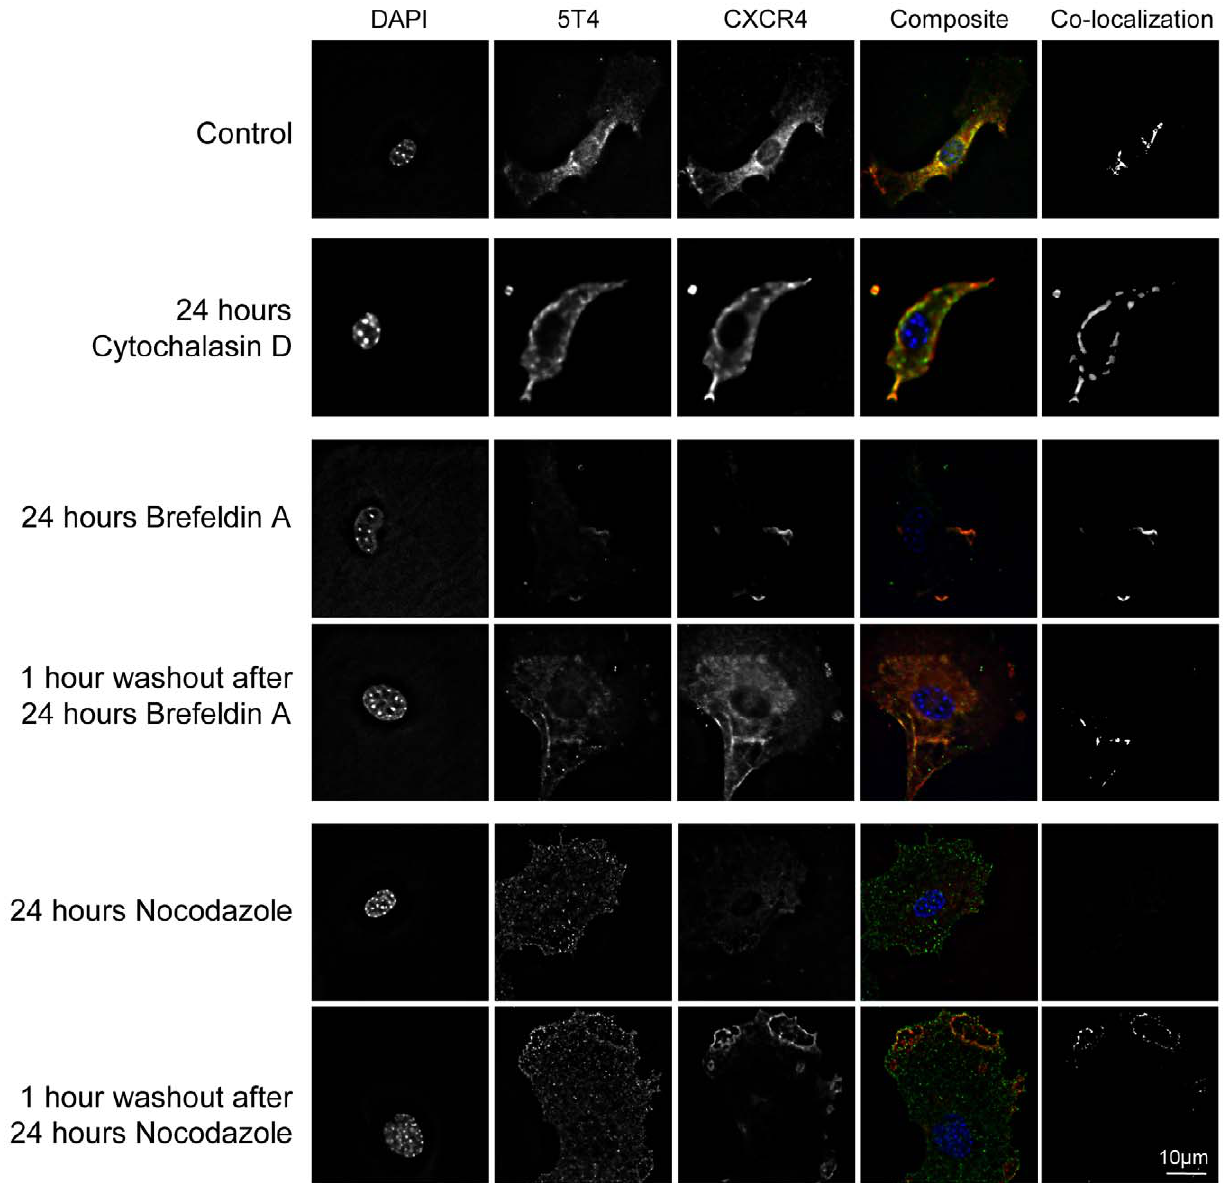
Figure 7. Effects of cytoskeleton, microtubule and Golgi disruption on the co-localisation pattern of 5T4 and CXCR4. Primary murine embryonic fibroblasts were assessed for their pattern of 5T4 and CXCR4 expression by immunofluorescence following 24 hours disruption of either the cytoskeleton (cytochalasin D), Golgi (brefeldin A) or microtubules (nocodazole) and 1 hour after drug washout. Cell surface expression of 5T4 (green) and CXCR4 (red) with regions of co-localization of the two antigens (seen as yellow) (also shown by co-localization analysis) are depicted.